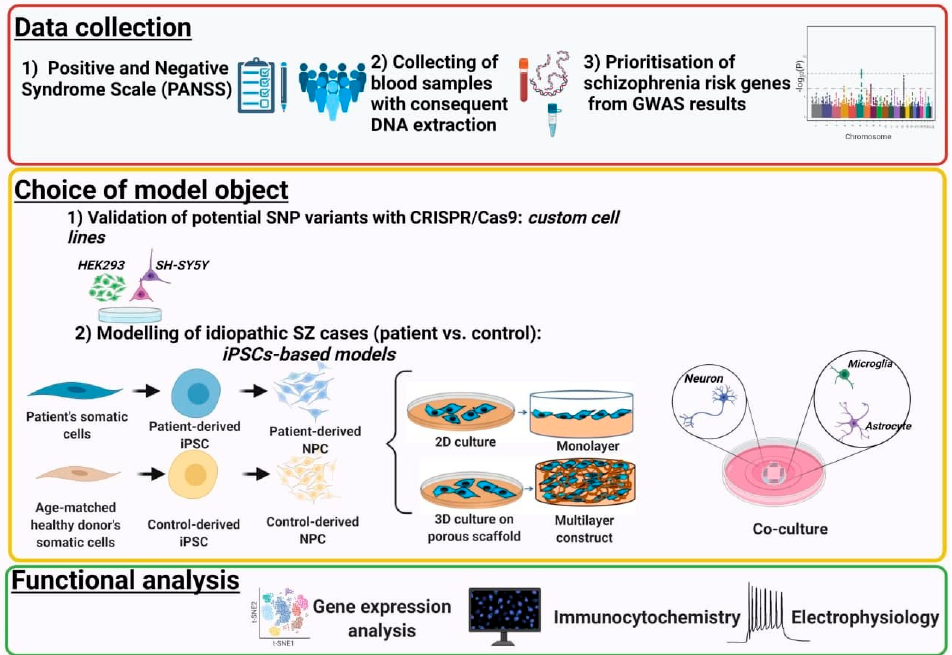
Figure 1. Rational design of SZ models. Data collection: choice of candidate genes and/or patients’ cohorts. Choice of model object: genetically engineered cell models for high-risk SZ cases and autologous iPSC-based models for idiopathic SZ cases. Functional analysis: transcriptome, cellular subtypes identification and morphology analysis and electrophysiology.